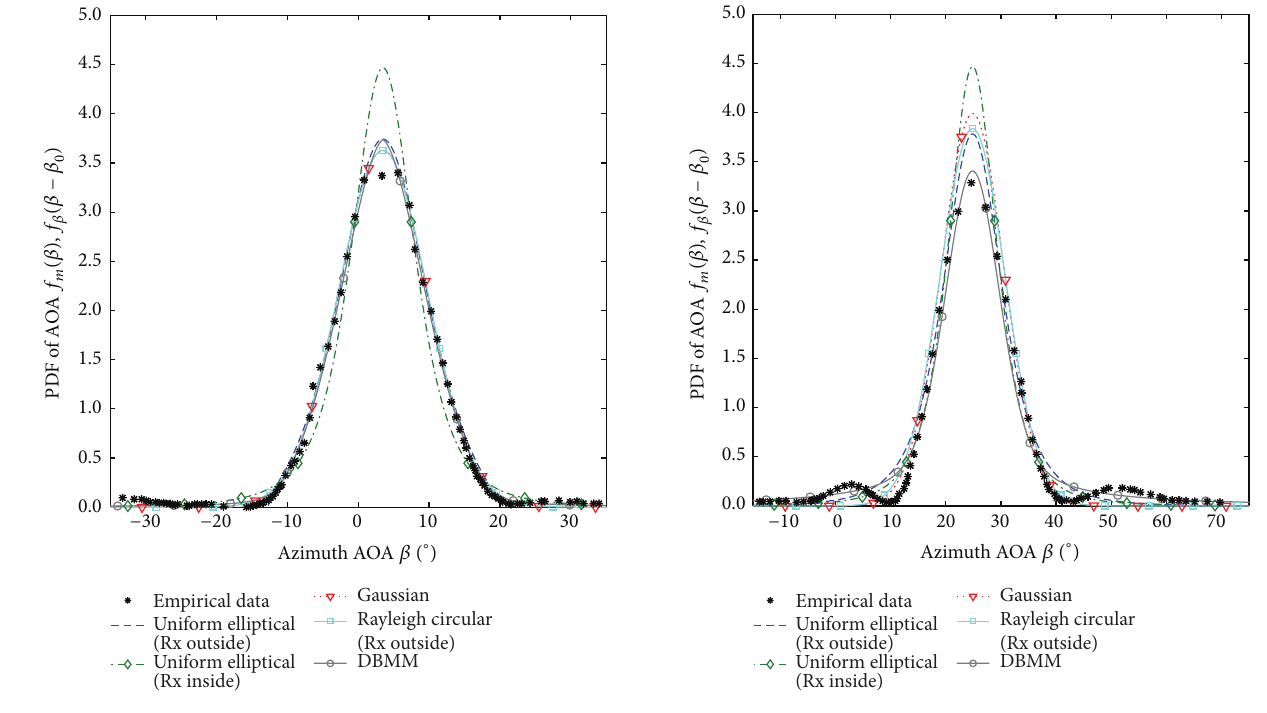
Figure 8: Fitting for various geometric models to the empirical data in Fleury et al. [29, Figure 16 ].